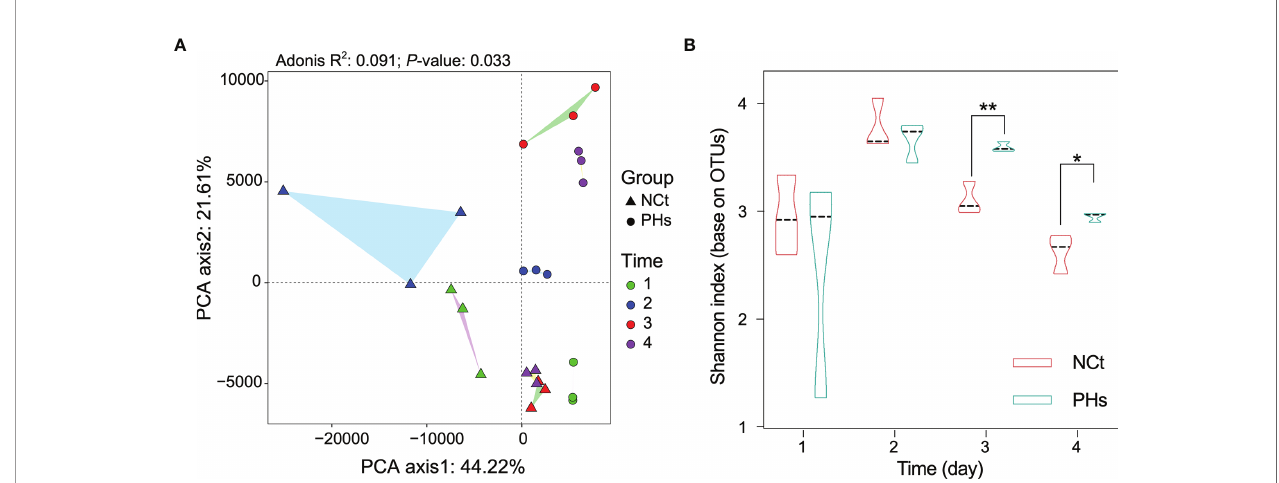
FIGURE 4 | Changes in the composition and diversity of the intestinal bacterial community in different treatments. (A) Principal component analysis (PCA) distinguishing the dissimilarity of the OTU pro fi les among all the gut bacteria of house fl y larvae samples. Repeated measures PERMANOVA was followed by Adonis ’ s correction for multiple comparisons. (B) Dynamics of the Shannon index of intestinal bacteria in the two groups of house fl y larvae. Data are shown as the mean ± SEM. The t-test is used for statistical data. * P < 0.05, ** P < 0.01.